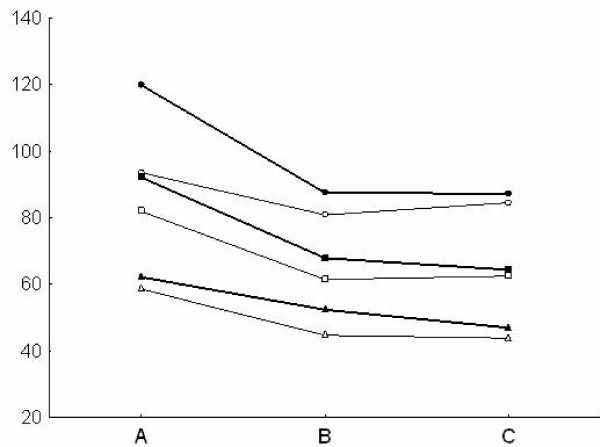
Basilar Artery: Mean of PSV (circle), TAMM (square) EDV (triangle) in TCD (narrow line) e TCCS (thick line) in the three groups of patients A, B, C.